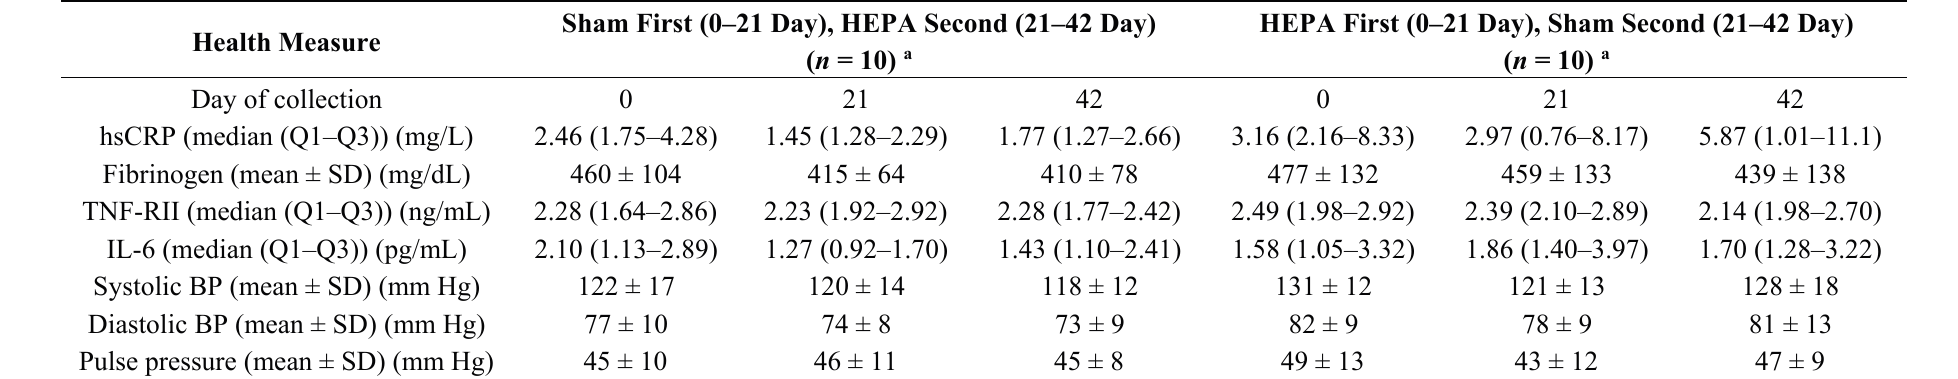
Table 4. Blood biomarker concentrations and blood pressure measurements stratified by filter